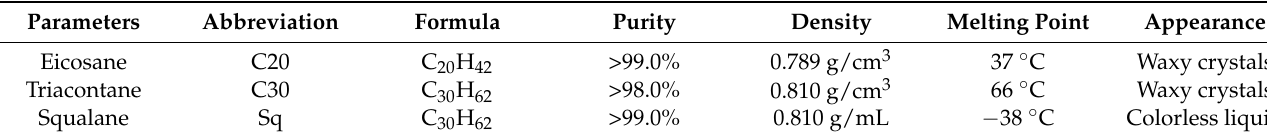
Figure 2. The molecular formula structure of additives. Table 2. Main parameters of